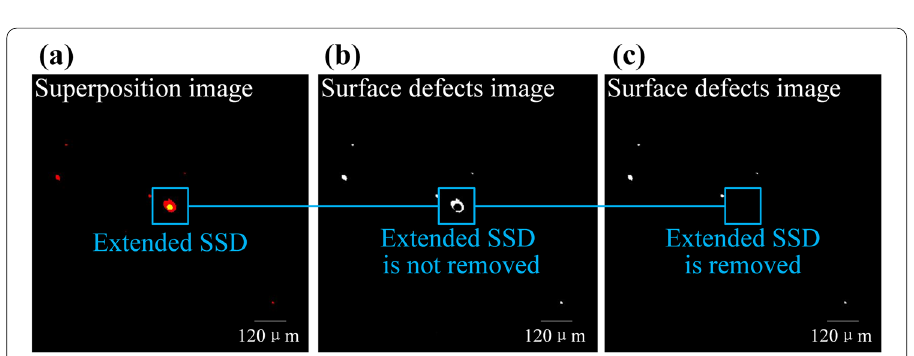
Fig. 4 Imaging and removal results of extended SSDs. a Superposition image. b SDs image (the extended SSD is not completely removed). c SDs image (the extended SSD is completely